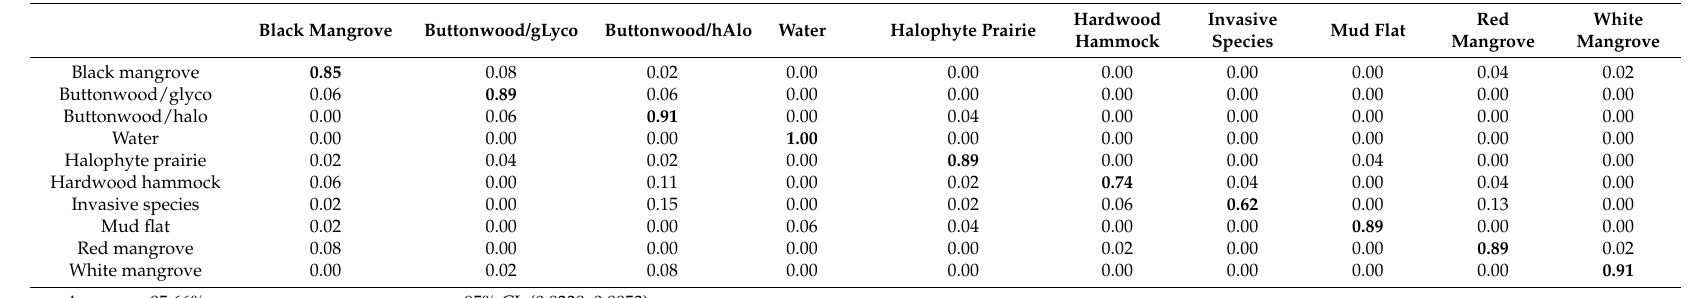
Table 4. Stratified-random probability accuracy assessment error matrix, stratifying by community types for the 71 km 2 study area, Flamingo, Everglades National Park, Florida. Rows are classification-derived map labels; columns are the reference labels. The main diagonal (in bold) shows the proportion of correctly classified pixels, the user’s accuracy. Because it was difficult to distinguish pixels of the two invasive species, Schinus terebinthifolius and Colubrina asiatica , and their area was small, those categories were combined for the accuracy assessment. Community types described in the text: Buttonwood/glyco = Buttonwood/glycophyte; Buttonwood/halo =